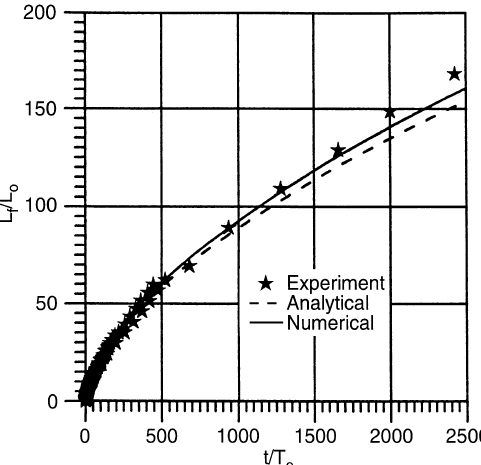
Fig. 7. Distance L f of the gravity current front from the cone top as a function of time t in non-dimensional variables. The scales are (see p L 0 = V g . Stars show Eq. 21) L 0 (cid:136) Q = (cid:133) 2 (cid:112) cos (cid:104) V g H E G m ), T 0 (cid:136)(cid:129)(cid:129)(cid:129) 2 experimental data, dashed line shows self-similar analytical solution (14), solid line shows the numerical solution calculated using the same boundary conditions as in Fig.